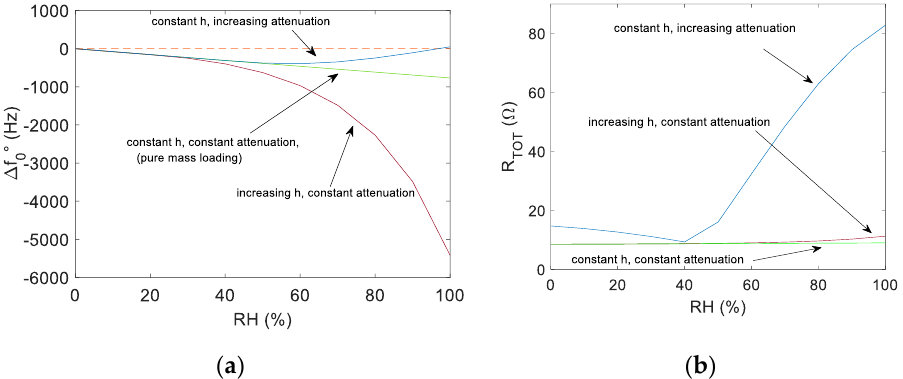
Figure 8. Simulated responses of a functionalized QCM as a function of the RH level (hence of the increasing film density); the film density initial value is 1000 kg/m 3 . ( a ) A frequency shift of the oscillator frequency (f 0° ) with respect to the frequency measured in dry air; ( b ) motional resistance. The simulations compare the spate effects of a thickness increasing proportionally to RH level and of an attenuation growing proportionally to the RH level. The simulations account for the effect of a thickness increasing the RH level proportionally for a normalized density larger than 27%, and for attenuation increasing proportionally to the density for RH levels higher than 45%.